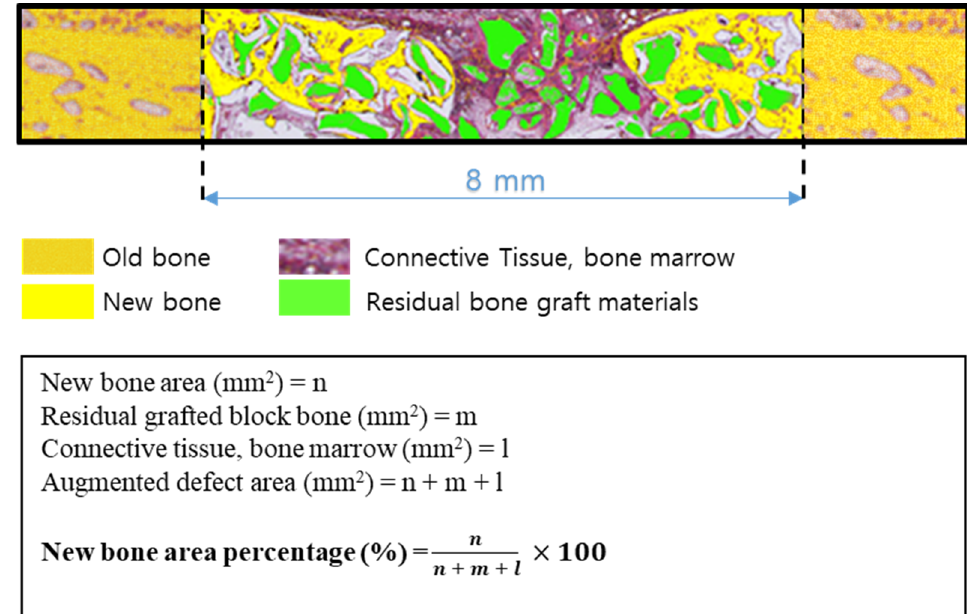
Figure 2. Schematic of histometric analysis.